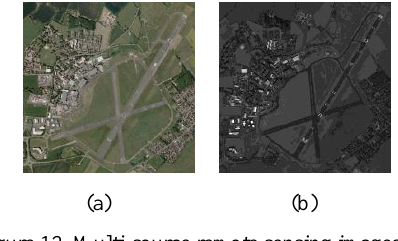
Figure 12 . Multi-source remote sensing images for matching. (a) Aerial image (Copyright Blue Sky International Ltd). (b) Geoeye satellite image (Copyright Digital Globe).